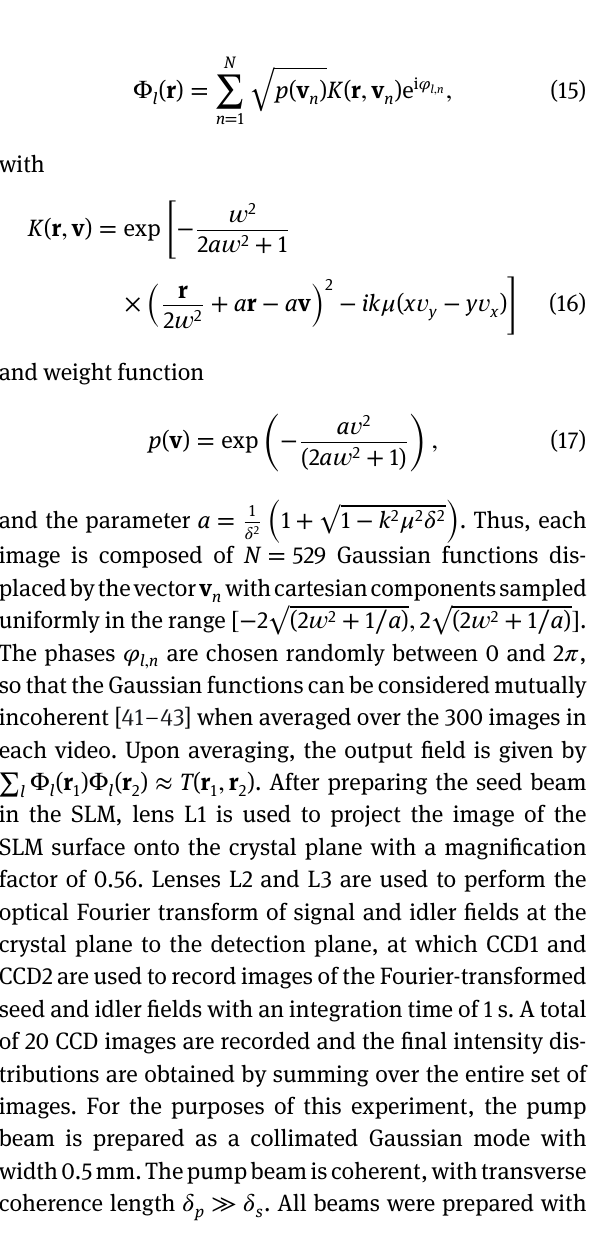
Figure 1: Experimental setup. A pump beam is incident on a nonlinear crystal producing parametric down-conversion. An auxiliary laser is used as a seed to stimulate the parametric emission aligned with the signal beam. It is prepared as a TGSM beam using a spatial light modulator (SLM), where a ( ∼ 20 s) movie of 300 phase-randomized phase/amplitude masks is used to produce the partially coherent seed field. Both seed and idler beams after the crystal are measured with a CCD